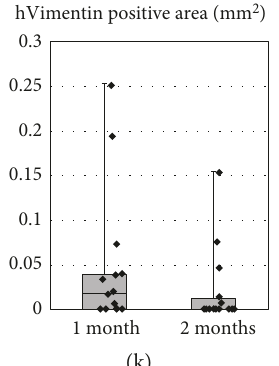
Figure 7: In vivo transplantation of TEC to rat osteochondral defects. (a – f) Macroappearance and Safranin-O staining (Saf-O) for each group at 1 month and 2 months. Inset boxes in the upper panels are magni fi ed in lower panels with the same frame. Representative data are shown ( N = 5 knees for the empty group, N = 6 knees for the hBM-TEC group, and N = 7 knees for the iNCMSC-TEC group at each endpoint). Histological assessments were conducted at two di ff erent points as shown in the macroimages ( “ P ” represents “ proximal section ” and “ D ” presents “ distal section ” ). Scale bars =1mm (macroimage), 500 μ m (upper panels of Saf-O), and 200 μ m (lower panels of Saf-O). (g, h) Human vimentin immunostaining of the iNCMSC-TEC group at 1 month and 2 months. Scale bars =500 μ m. (i) Macroscopic score based on their gross appearance [57]. Averaged score with standard deviation is shown. ∗ P < 0 05 by the Steel-Dwass test. (j) Histological grading by the O ’ Driscoll scoring system based on Saf-O staining using two specimens ( “ P ” and “ D ” ) per each knee. Data are expressed as the mean ± SD for each group. ∗ P < 0 05 by the Steel-Dwass test. (k) The quantitation of transplanted iNCMSCs remaining at the implantation site was calculated from their hVimentin-DAB positive area. Data are shown as box-and-whisker plots and dot plots. Abbreviations: TEC: tissue-engineered construct; hBM: human bone marrow mesenchymal stem cell; iNCMSC: induced neural crest-derived mesenchymal stem